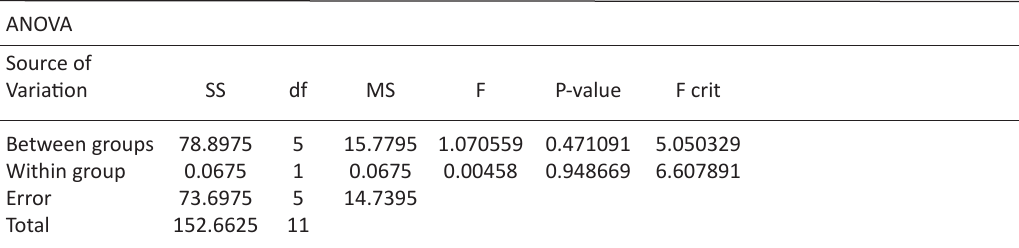
Table 3. Results obtained from the ANOVA analysis for methanol and hexane extracts for C. cinereum at 100%, 75%, 50%, 25%, 10% and 5% concentration against S. aureus